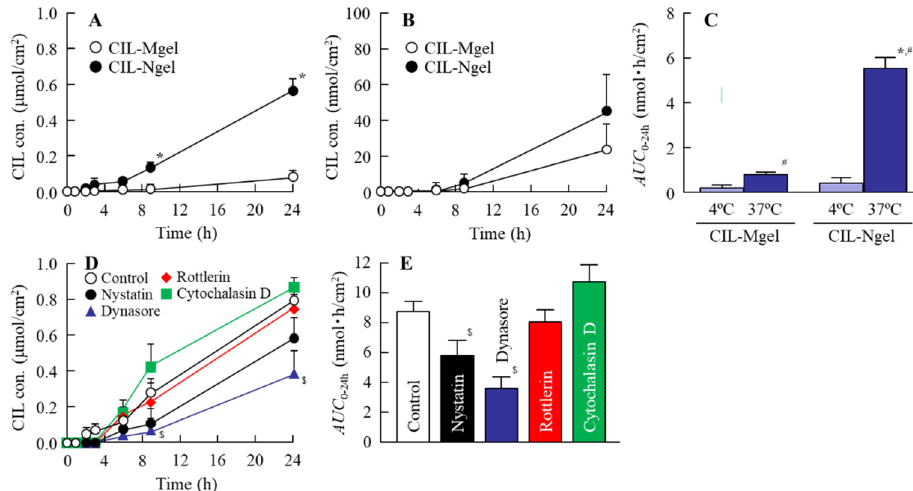
CIL was released from the CIL-Ngel as NPs.